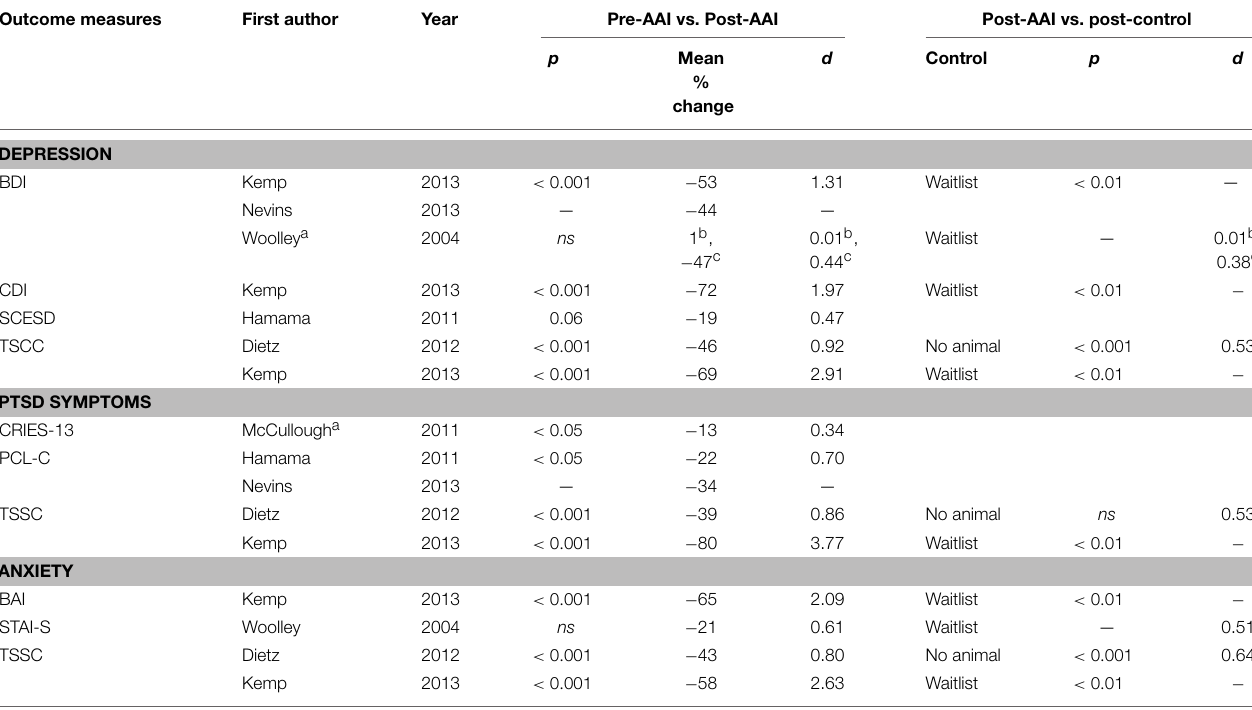
TABLE 5 | Percent change and effect size of most commonly reported outcomes in quantitative studies. Outcome